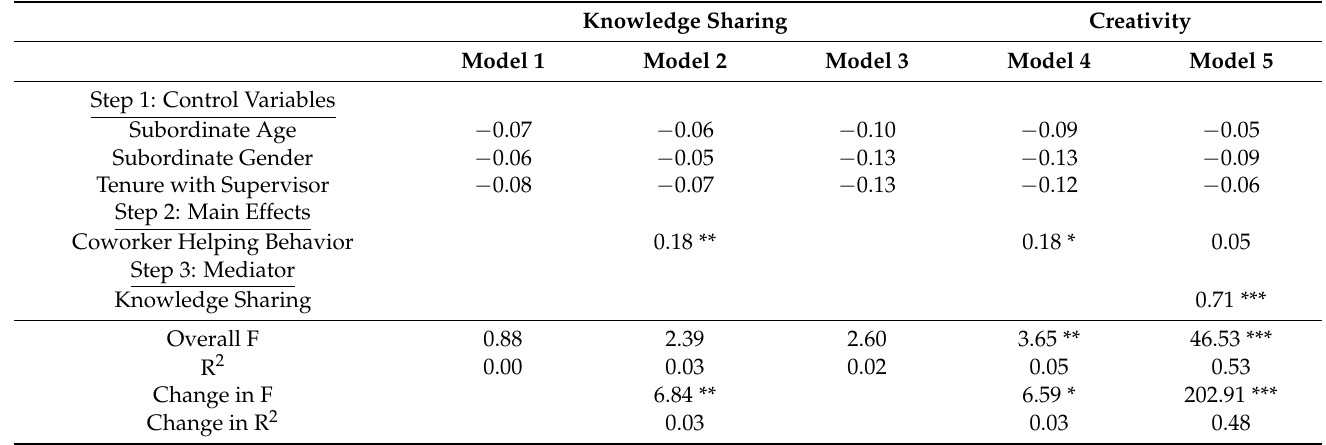
Table 2. Hierarchical regression results for simple mediation.